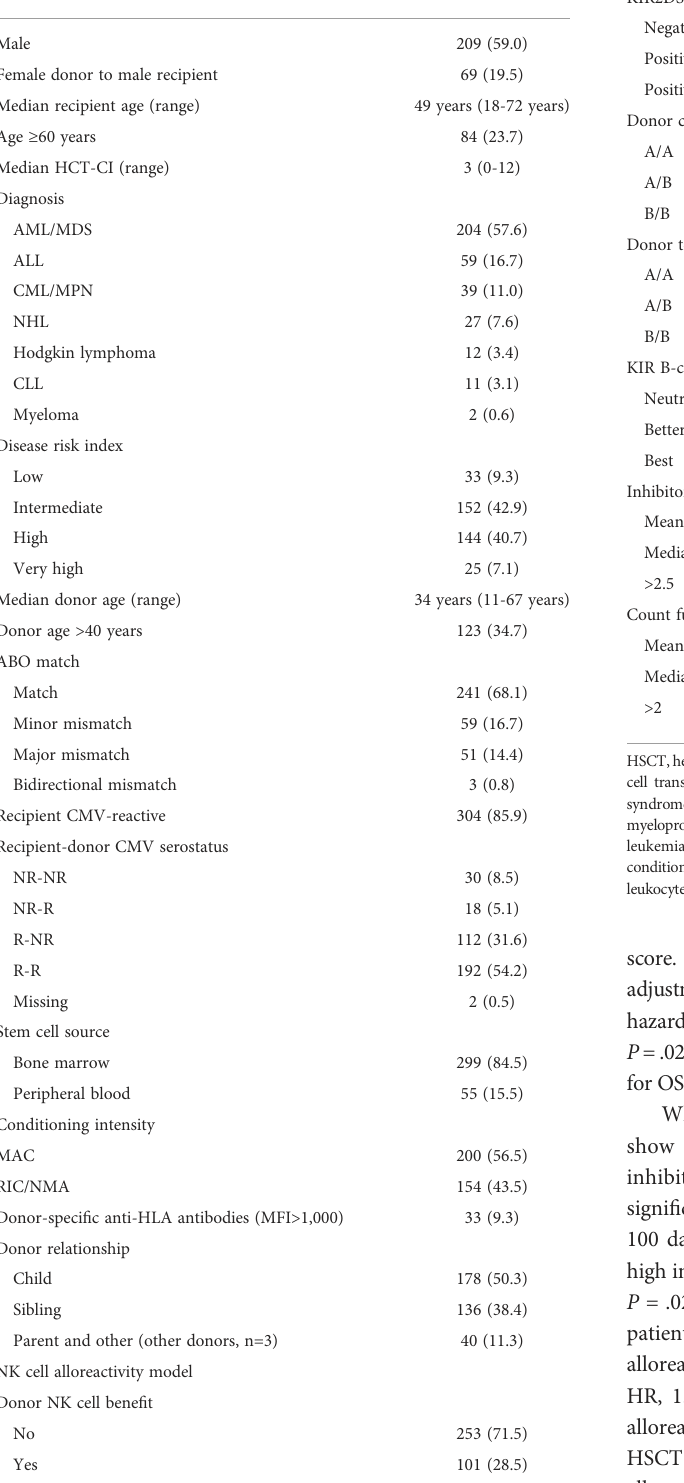
TABLE 1 Patient and HSCT-related characteristics and NK cell alloreactivity in our cohort of patients who underwent haploidentical HSCT (n =